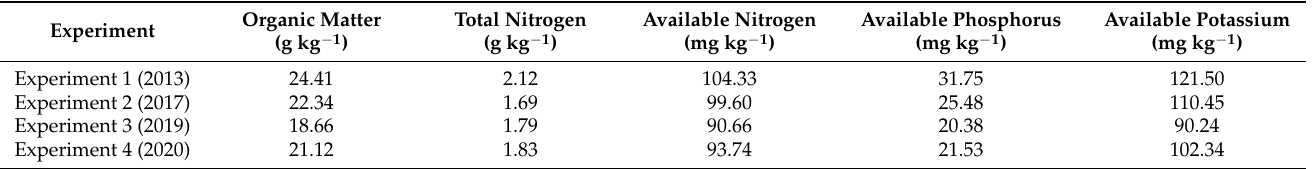
Table 2. Average values for selected soil characteristics of composite topsoil samples (0–20 cm) from the experimental fields in 2013, 2017, 2019, and 2020.